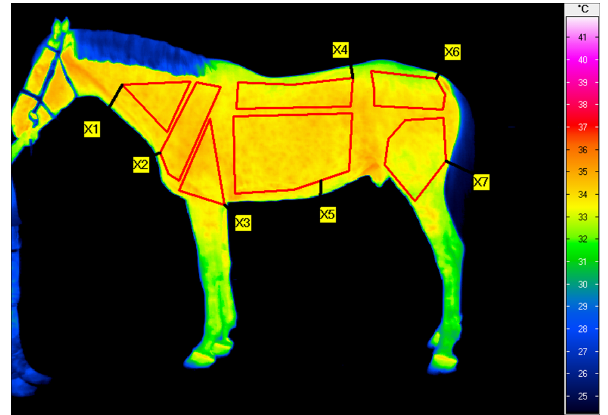
Figure 1. Example thermographic image of the left side of the horse before exercises on the treadmill with the seven regions of in- terest (ROIs) shown: neck (RO1), shoulder (ROI2), elbow (ROI3), back (ROI4), chest (ROI5), gluteus (ROI6), quarter